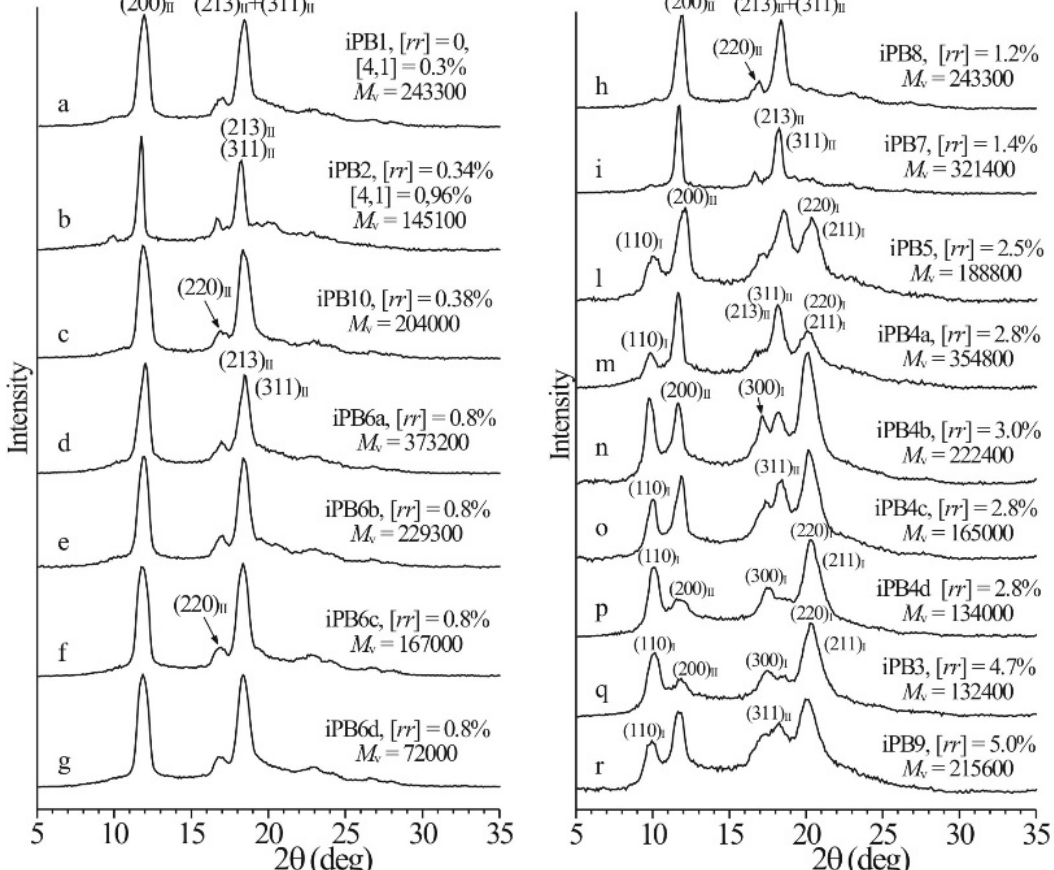
Figure 10. X-ray powder diffraction profiles of samples of iPBu of different stereoregularity crystallized from the melt by cooling the melt to room temperature (or lower temperature) at cooling rate of 10 °C/min. The (110) I , (300) I and (220) I /(211) I reflections of form I at 2θ = 9.9°, 17.3° and 20.5°, and the (200) II , (220) II and (213) II /(311) II reflections of form II at 2θ = 11.9°, 16.9° and 18.3° are indicated. Reproduced with permission from Ref. [80], copyright 2009 American Chemical